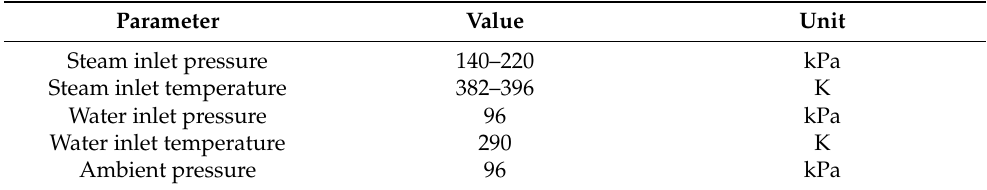
Table 15. The experimental parameters of steam, water, and pressure in